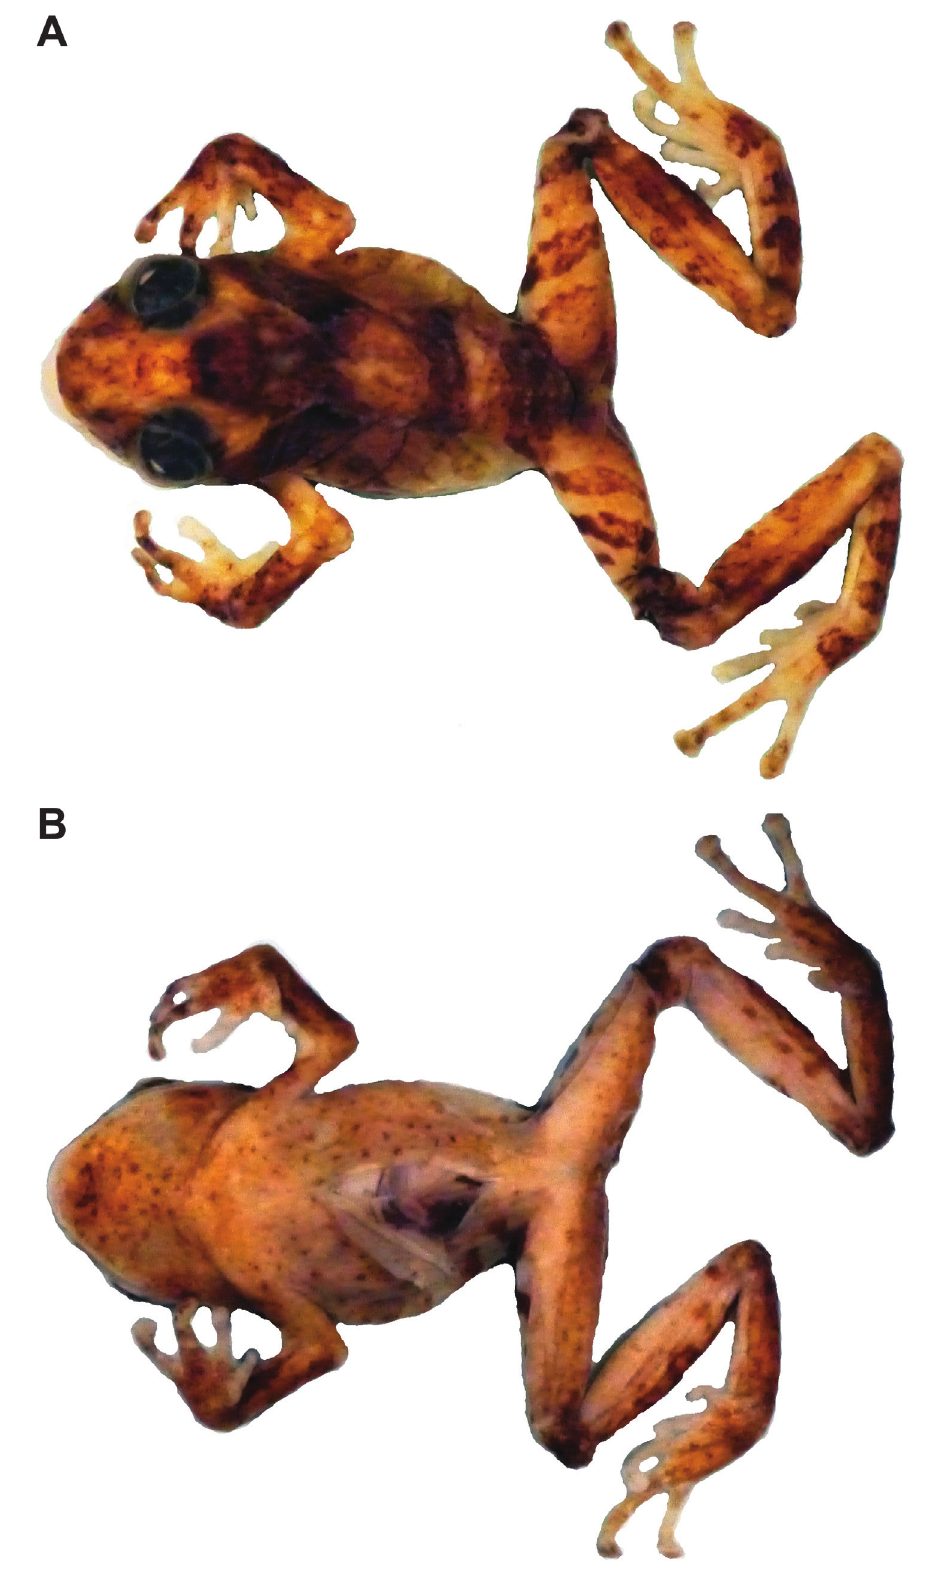
Fig. 4 . Preserved holotype (MUSM 31102, SVL 14.1 mm) of Pristimantis boucephalus sp. nov. A . Dorsal view. B . Ventral view. Photos by E.